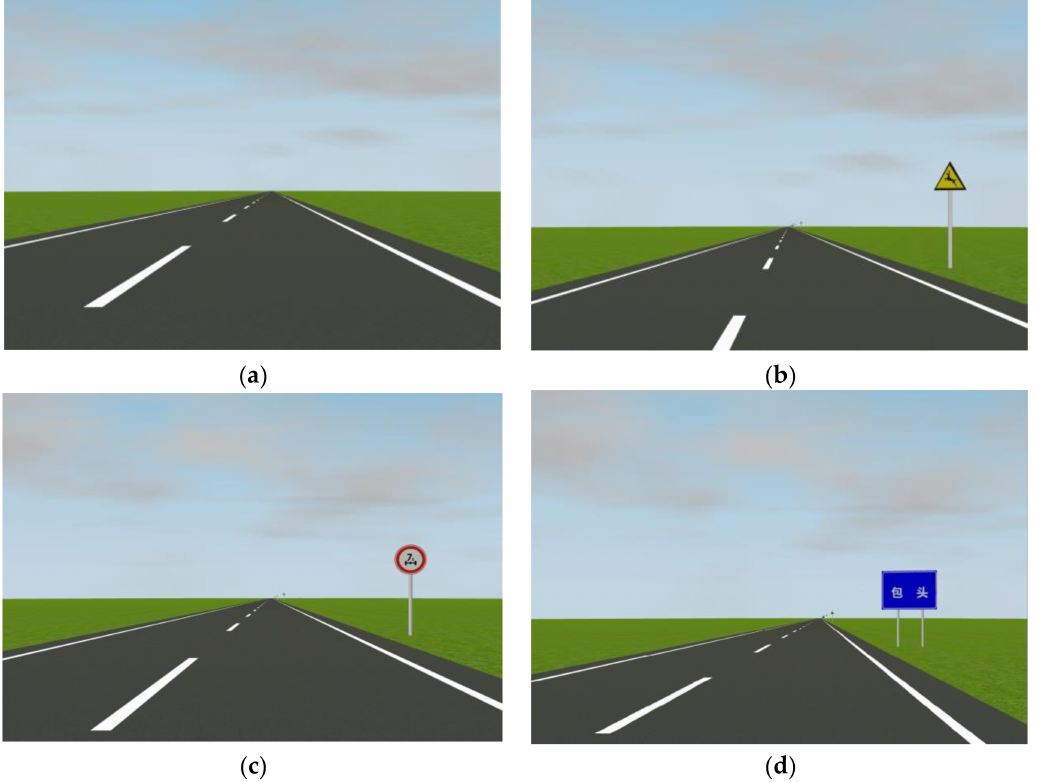
Figure 2. Part of traffic signs of simulated driving scenarios. ( a ) No traffic signs; ( b ) add warning signs; ( c ) add regulatory signs; ( d ) add guide